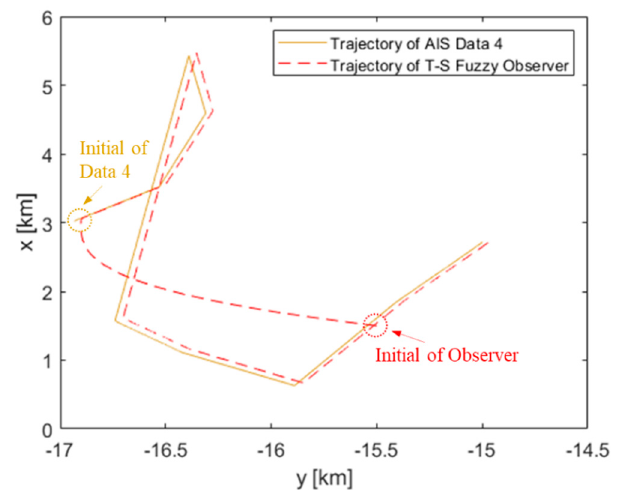
Figure 18. Observed results of AIS data 4.